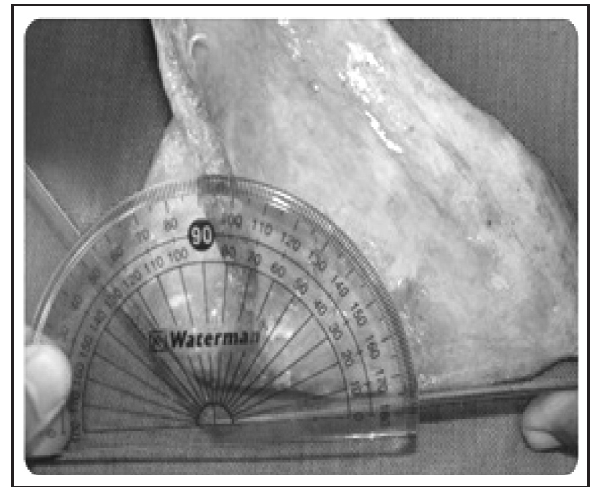
Figure 5. Measurement of medial angle. 5. Acromion angle: It was measured as the angle where the lower border of the crest of the spine becomes continuous with the lateral border of the acromion process. For measuring this angle, a scale was placed along the lateral border of the acromion and other scale was placed along the inferior border of the acromion and the angle between both was measured with the help of protractor. 2 (Figure 6).